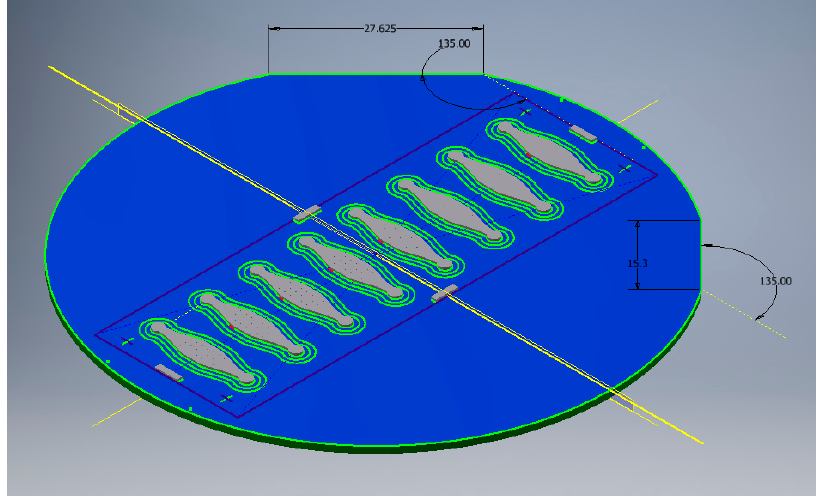
Figure 1. The CAD design of the shim (diameter = 85 mm). The number in the figure is in mm.